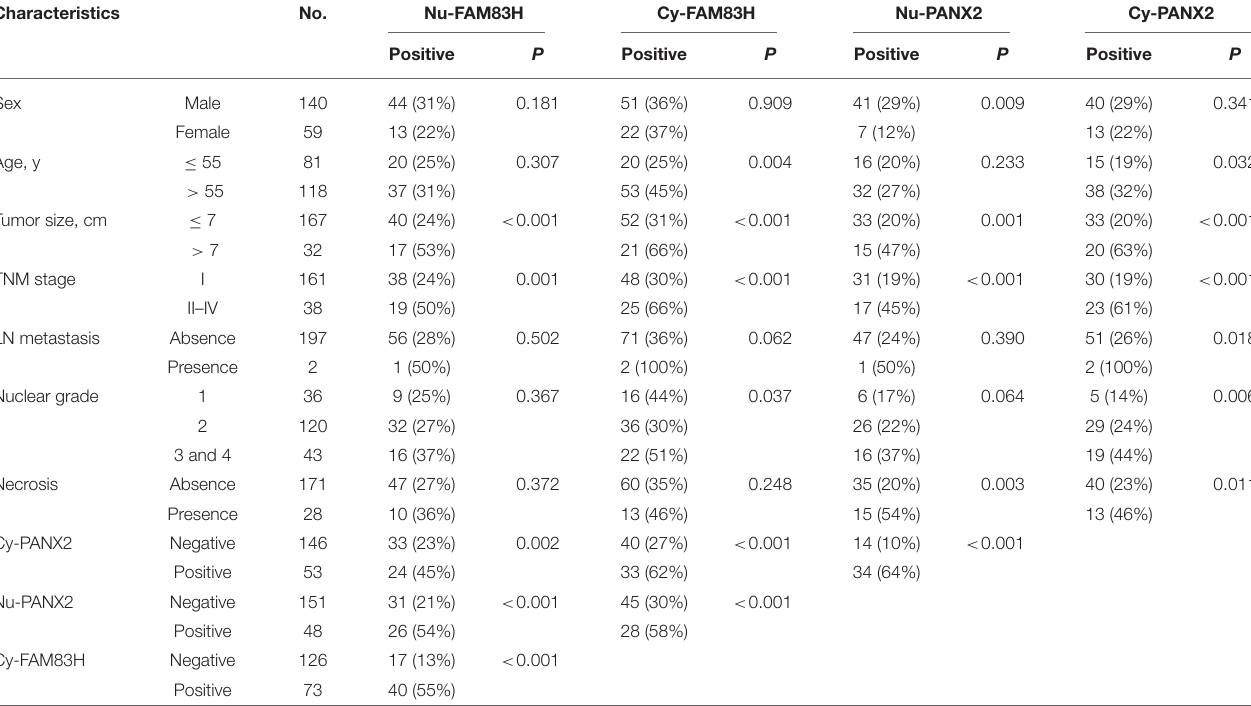
TABLE 2 | Clinicopathologic variables and the expression of FAM83H and PANX2 in clear cell renal cell carcinomas. Characteristics